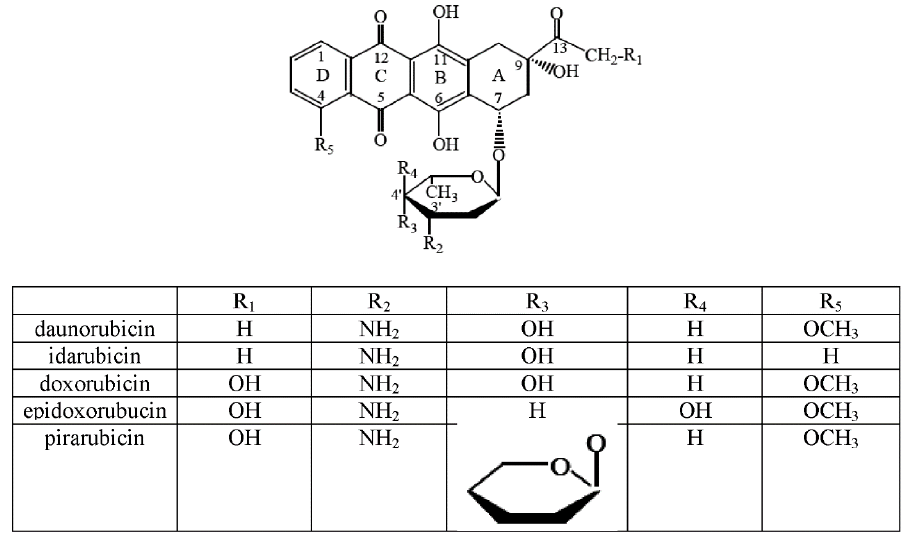
Figure 1. Structural formula of the selected anthracyclines regarding the functional groups of the individual compounds.